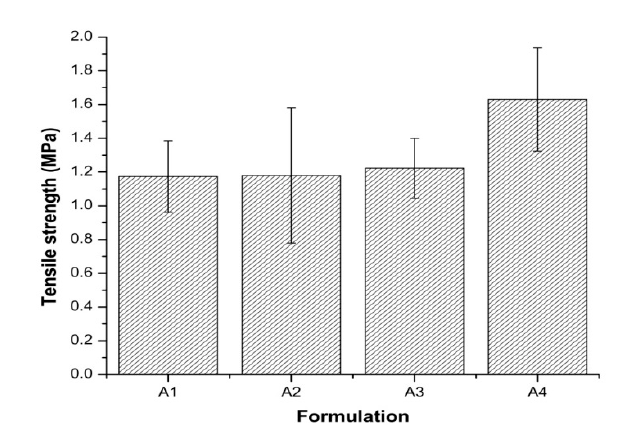
Figure 6. Tensile strength of all formulations.